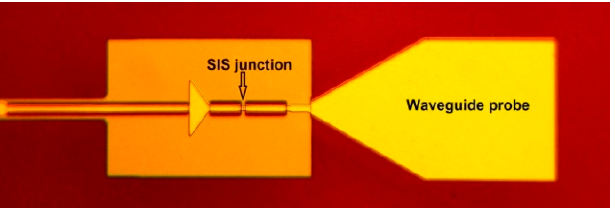
Figure 6. Photo of the SIS mixer structure for the frequency range 211–275 GHz. The SIS element is inserted in the planar structure formed by segments of coplanar and microstrip Nb-SiO 2 -Nb lines. The waveguide probe is shown on the right.